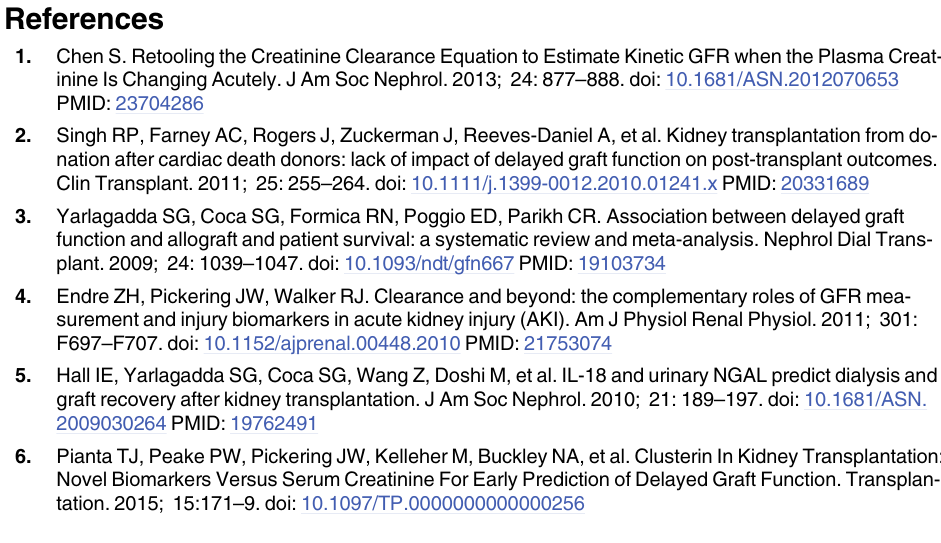
tients. Max Δ pCysC/d was estimated using back calculation from the CKD-EPI formula, and al- ternatively using the Sjostrom formula, and a fixed value (3 mg/L/d). Optimal cut-offs were values with the maximal Youden index for prediction of DGF. Key: AUC: area under the receiver operator characteristic curve; NPV: negative predictive value; PPV: positive predictive value. S3 Table. Sensitivity analysis for prediction of DGF using KeGFR expressed as mL/min. (expressed in mL/min) and KeGFR (mL/min) were produced by using the rele- KeGFR sCr pCysC vant reference formula (producing KeGFR, expressed in mL/min/1.73m 2 ) and multiplying by BSA/1.73 (body surface area, calculated using the formula of Dubois and Dubois: BSA = 0.007184× W 0.425 × W 0.725 .) Key: AUC: area under receiver operator characteristic curve. at 4h since no P values listed for difference with reference formula. a: there is no KeGFR pCysC 0h pCysC data were available. S4 Table. KeGFR prediction of DGF compared with unadjusted eGFR and sCr including deceased and live donor kidneys. Four patients commenced dialysis between 4h and 8h, leav- ing 78 patients for analysis at 8h and 12h. Key: AUC: area under receiver operator characteris- tic curve. P values listed for difference with AUC-sCr. a: p > 0.05 for difference with pCysC. b: at 4h since no 0h pCysC data were available. Characteristics of the co- there is no KeGFR pCysC hort have been previously